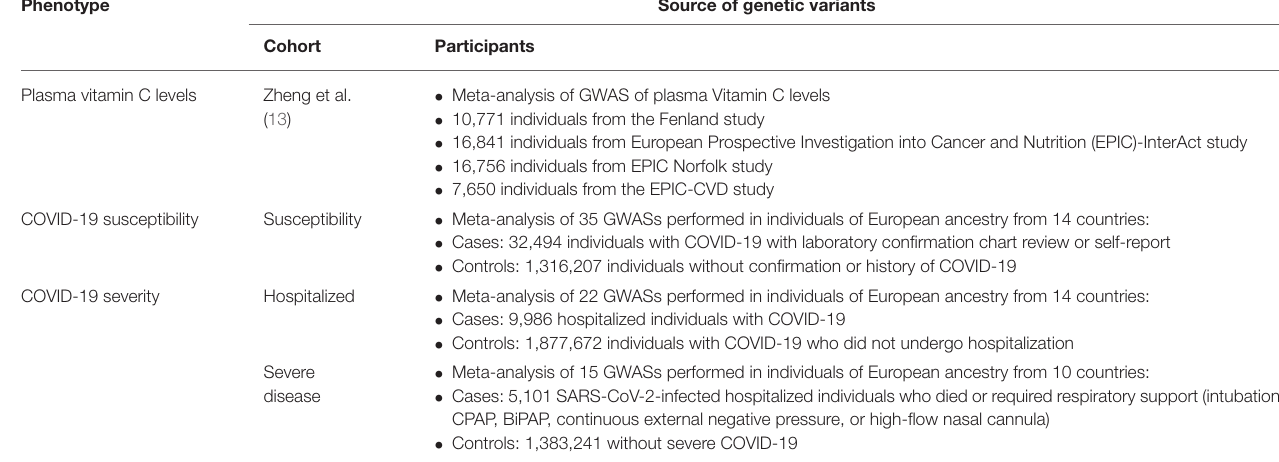
TABLE 2 | Sources of data for the analysis.